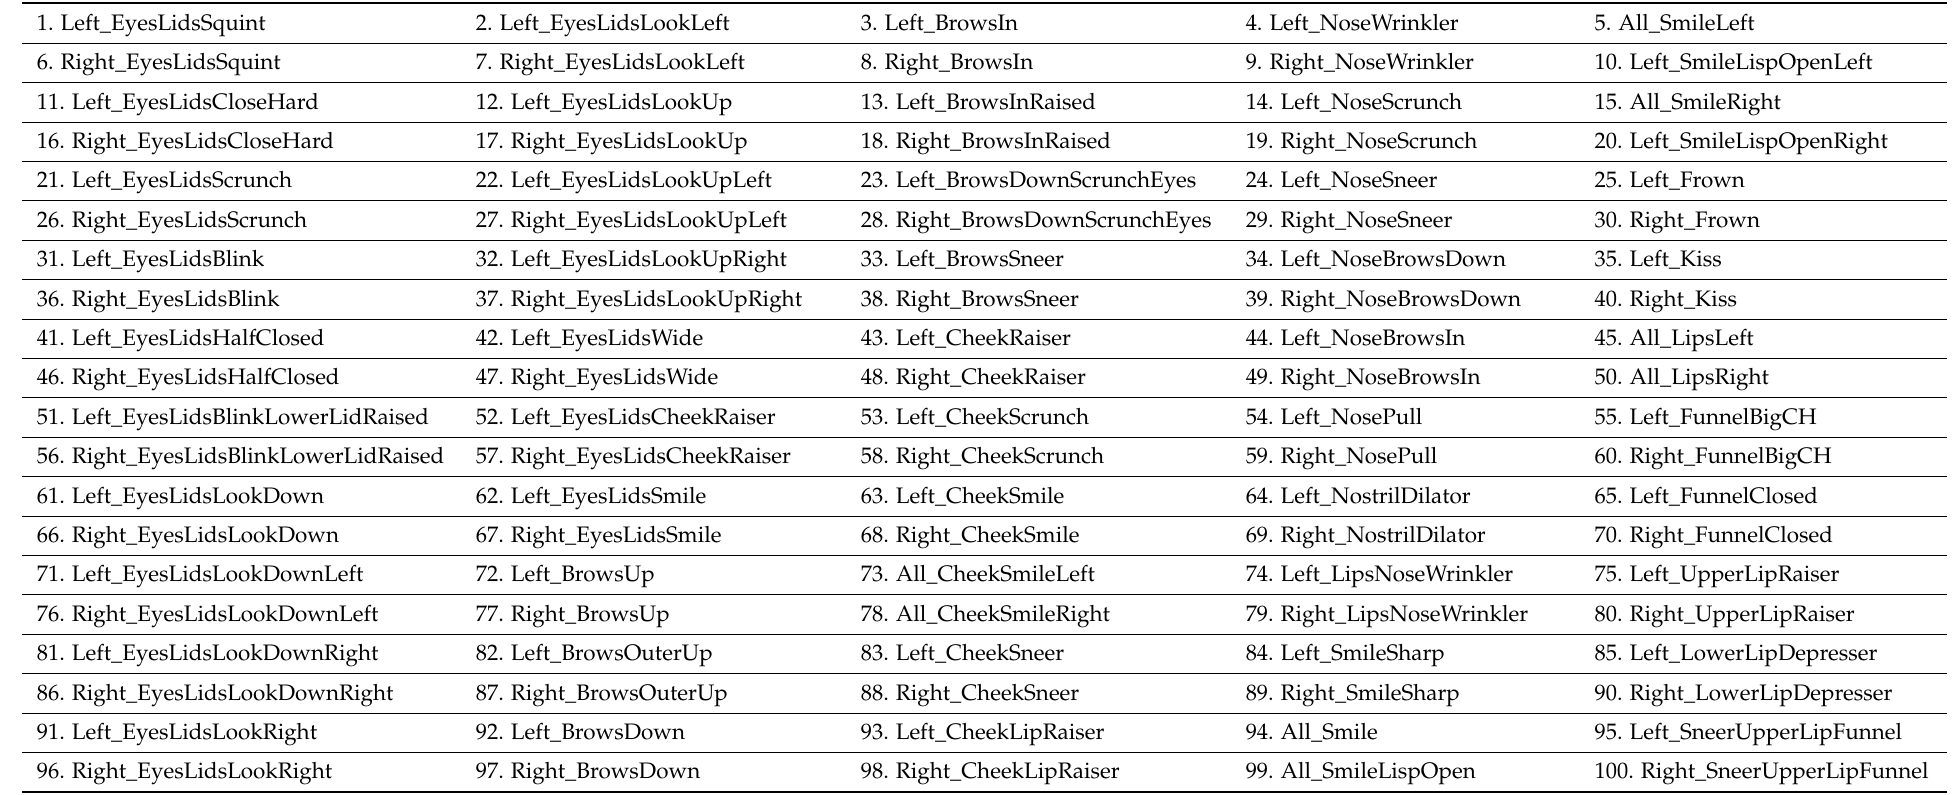
Table 1. Overview of major morph targets associated with Truli’s emotional